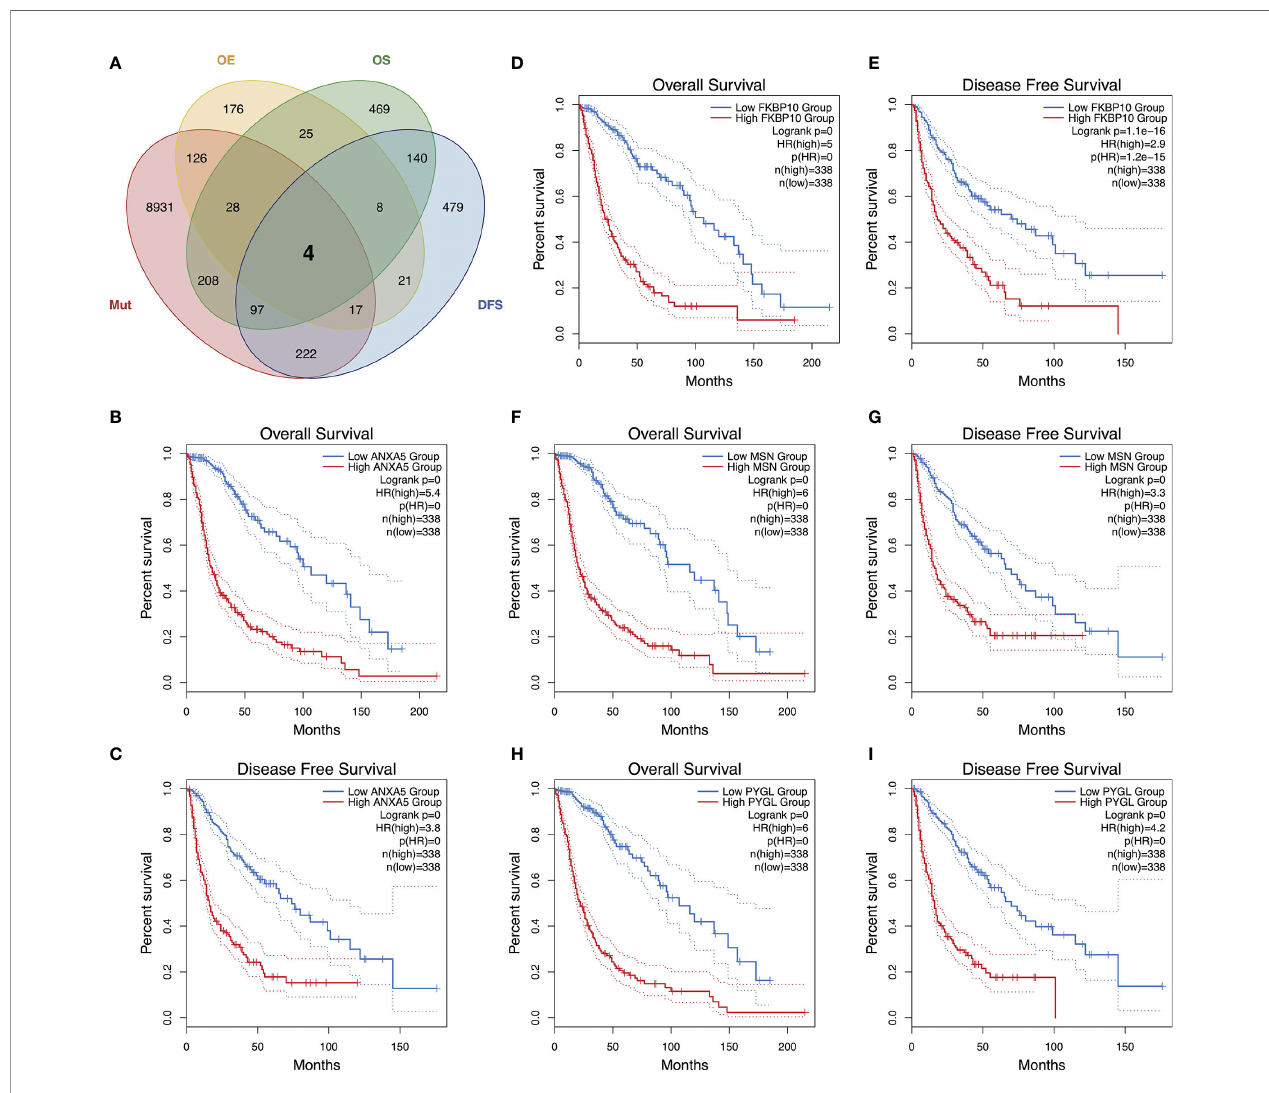
FIGURE 2 | Identi fi cation of tumor antigens associated with glioma prognosis. An upset plot of potential tumor antigen candidates with overexpression (OE), mutation (Mut), OS, and DFS in glioma (A) . Kaplan – Meier OS and DFS curves comparing the groups with high and low expressions of ANXA5 (B, C) , FKBP10 (D, E) , MSN (F, G) , and PYGL (H, I) in